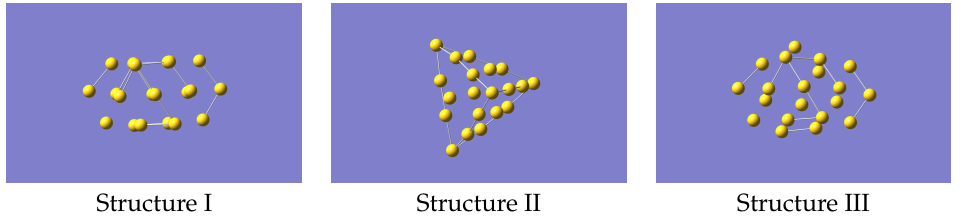
Figure 1. Structures of Au 20 used as starting geometries for generating data to train the machine learning